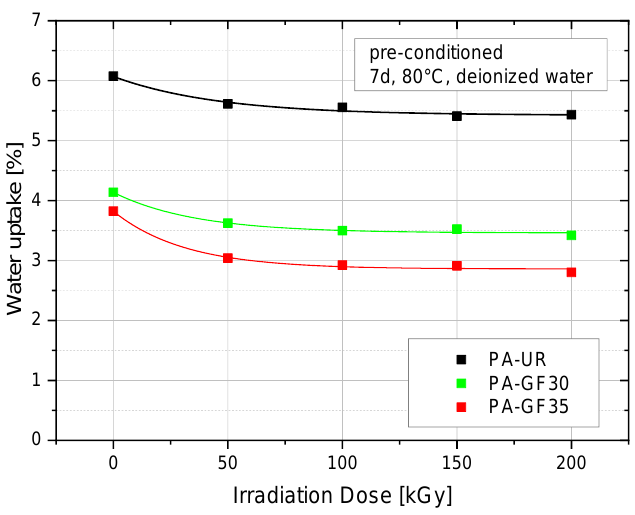
Figure 5. Water uptake as a function of irradiation dose of three different PA grades.